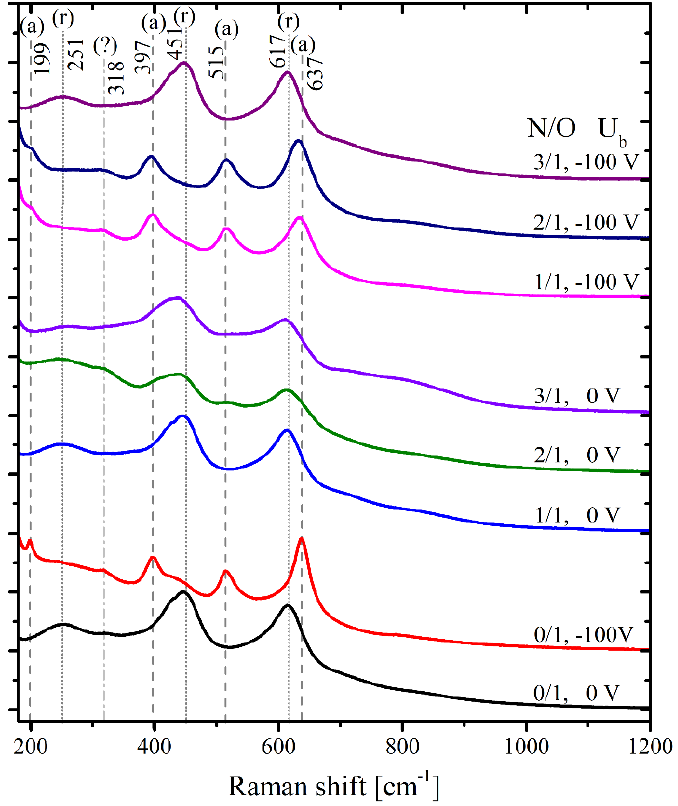
Figure 2. Raman spectra of the NiTi surfaces. Order of the spectra (from bottom to top): (1) N/O = 0/1, U = 0 V; (2) N/O = 0/1, U = − 100 V; (3) N/O = 1/1, U = 0 V; (4) N/O = 2/1, U = 0 V; (5) N/O = 3/1, U = 0 V; (6) N/O = 1/1, U = − 100 V; (7) N/O = 2/1, U = − 100 V; (8) N/O = 3/1, U = − 100 V. The vertical dashed lines indicate the Raman lines of anatase (a); the dotted lines denote the Raman lines of rutile (r). Spectra have been vertically shifted for